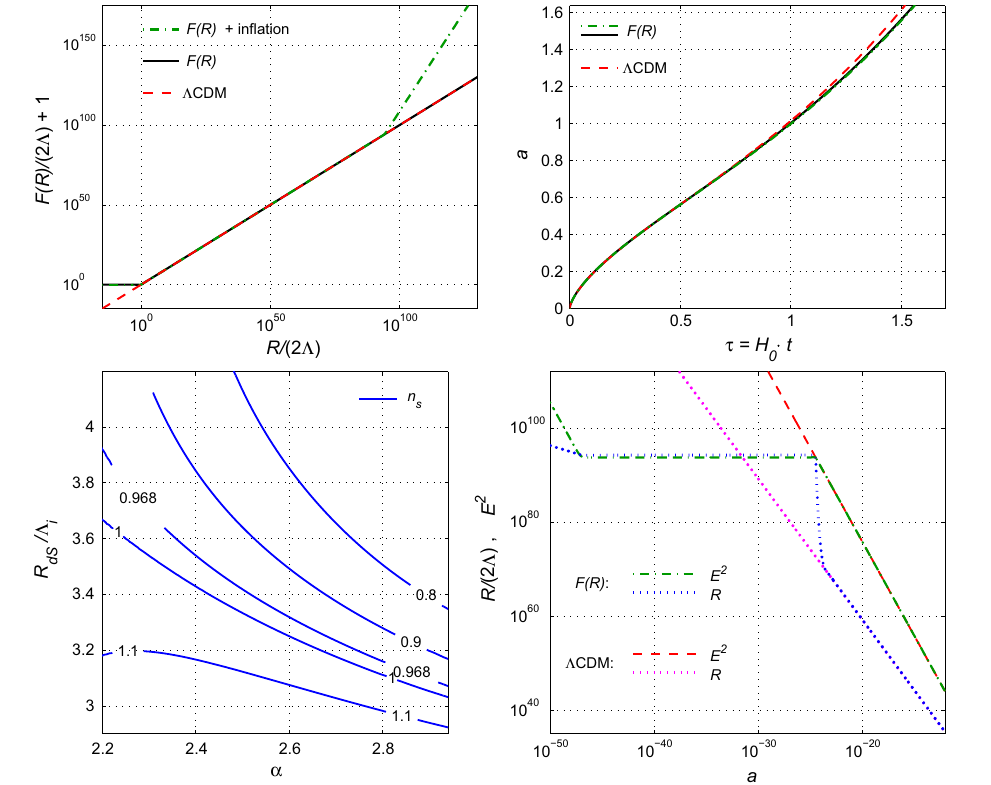
Fig. 6 Plots of F ( R ) (top-left), a (τ) (top-right), E 2 ( a ) and R ( a ) (the bottom-right panel) for the models: (3.1), (6.1) and the (cid:2) CDM model with the parameters from Table 3. In the bottom-left panel the level lines of n s are shown for the model (6.1)